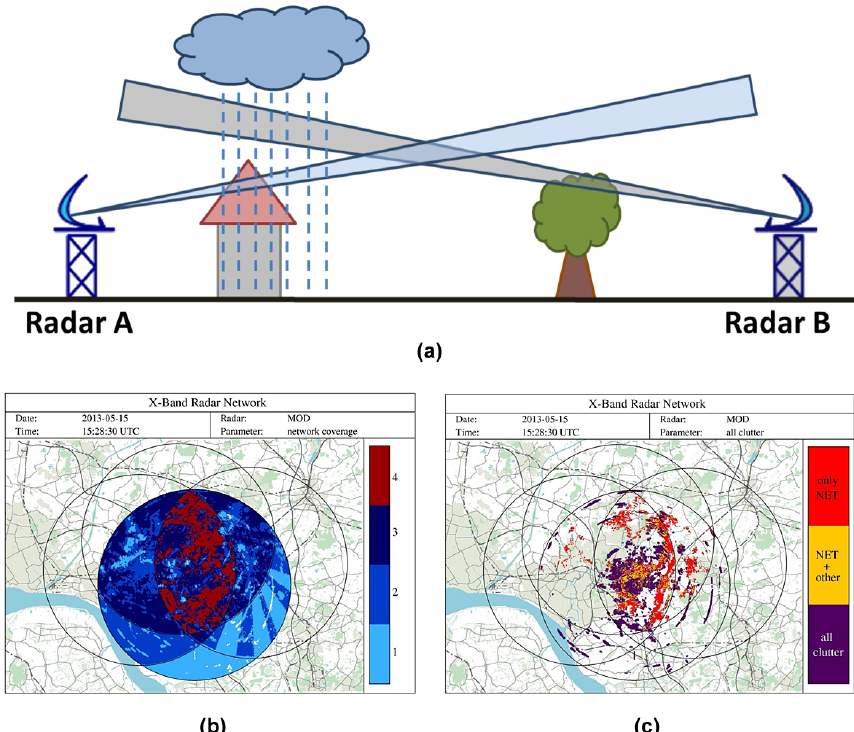
Figure 6. (a) Sketch of obstacles and precipitation as seen from two different radars; (b) coverage within the X-band radar network and (c) clutter range gates detected any clutter algorithm (violet) by the network algorithm and any other clutter algorithm (yellow), and by the network algorithm only